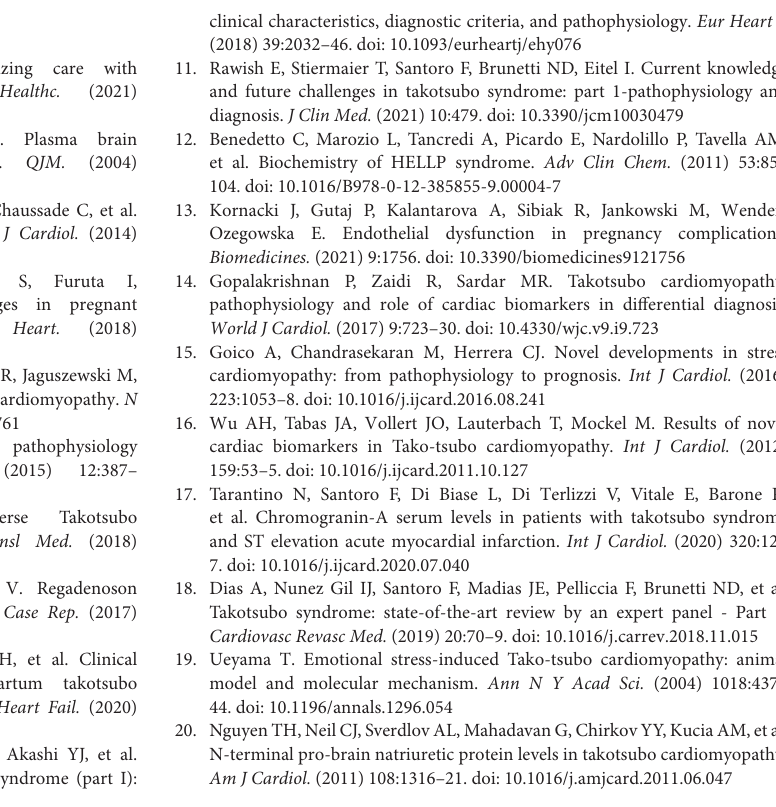
recovery of the basal left ventricular wall motion. Supplementary Figure 1 | Timeline. I.V, intravenous; HELLP, hemolysis elevated liver enzymes and low platelets count; TTE, transthoracic echocardiography; ACE, angiotensin conversion enzyme; LVEF, left ventricular ejection fraction; TKS, Takotsubo syndrome; MRI, magnetic resonance imaging; cTnThs, cardiac high-sensitivity troponin I; cTnIhs, cardiac high-sensitivity troponin I; NT-proBNP, N-terminal prohormone of brain natriuretic